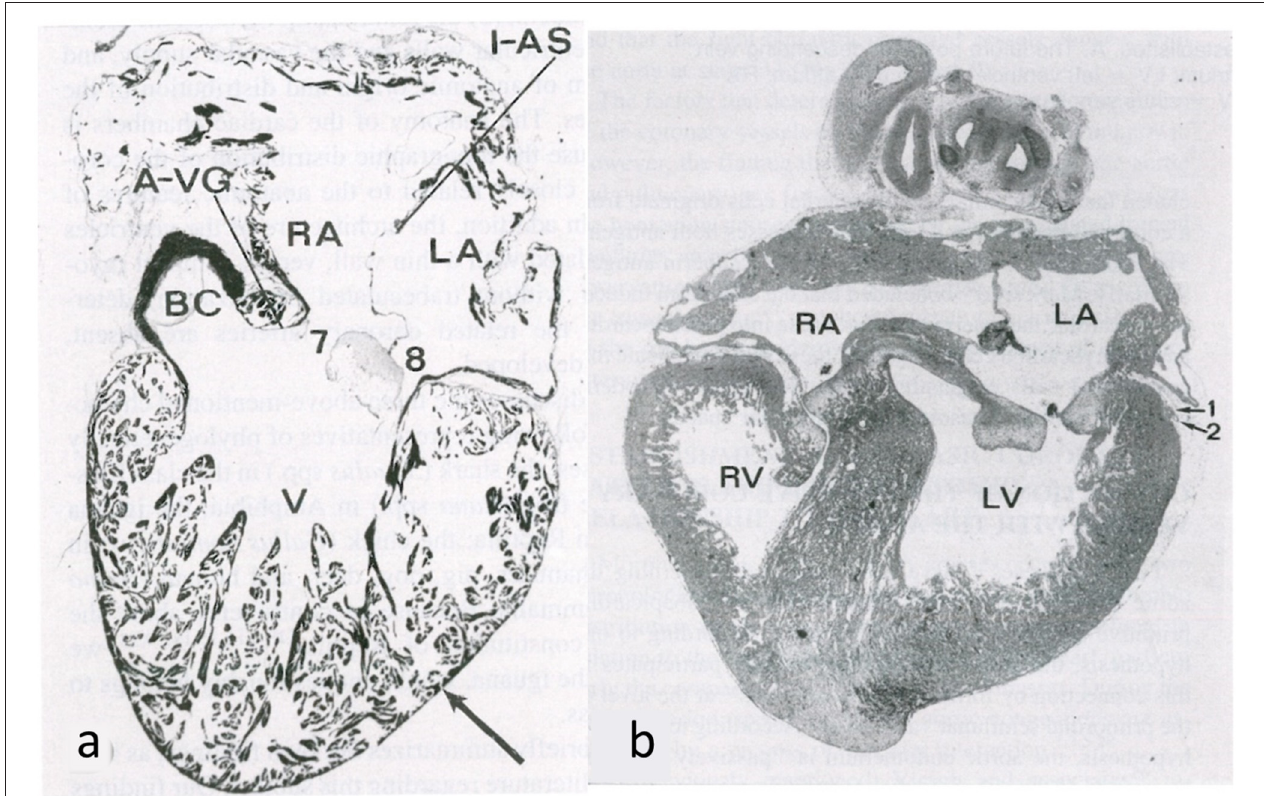
FIGURE 12 | Embryology of the myocardium. (a) Spongy myocardium from a mature fog with blood supply deriving directly from the endocardium of the ventricular cavities. (b) The myocardium of a fetal chick heart becomes compact, with blood supply deriving from the subepicardial vasculature. From de la Cruz et al. (13).